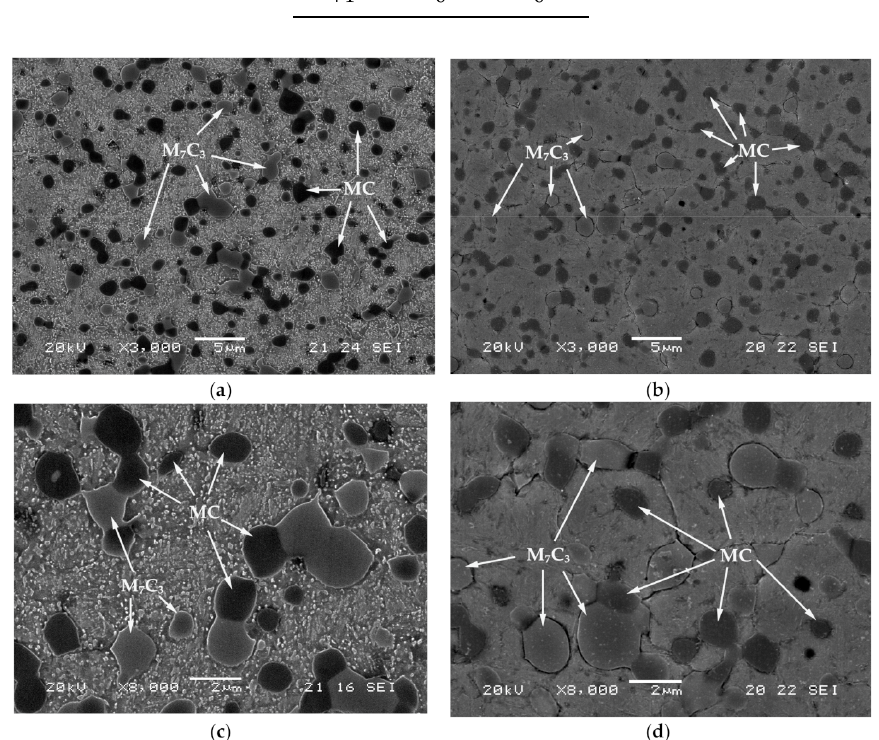
Figure 5. Secondary electron images (SEI) of: ( a ) microstructure corresponding to Experiment 2; ( b ) microstructure corresponding to Experiment 5; ( c ) microstructural details of Experiment 2 observed at a higher magnification; ( d ) microstructural details of Experiment 5 seen at a higher magnification. It can be seen that the sample corresponding to Experiment 2 has a higher density of secondary carbides. Images were obtained by scanning electron microscope (SEM).